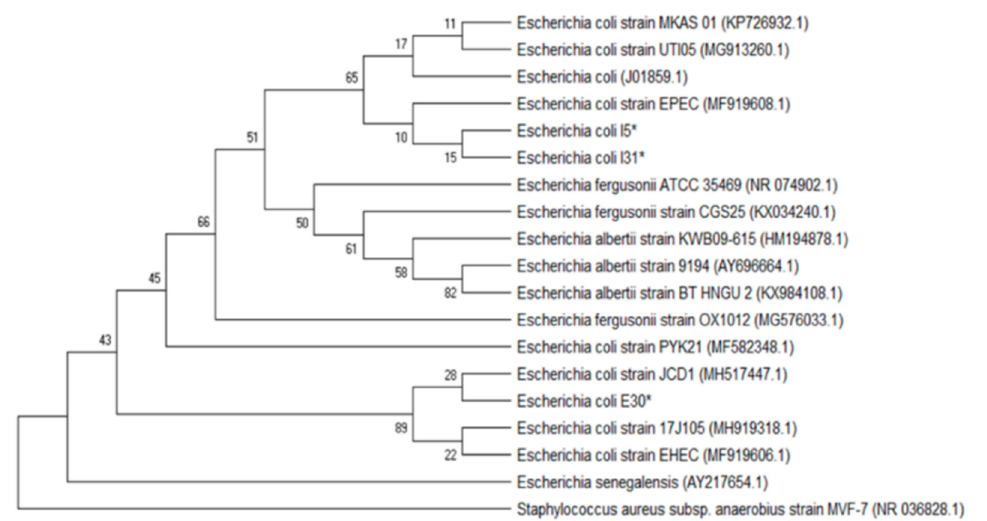
Figure 5. Phylogenetic tree based on the 16 S rRNA gene sequences of the Eschericha coli isolates and reference sequences. The analysis included 19 sequences selected from GenBank, and the access number is given in parenthesis. An asterisk identifies the bacterial isolates from this study.